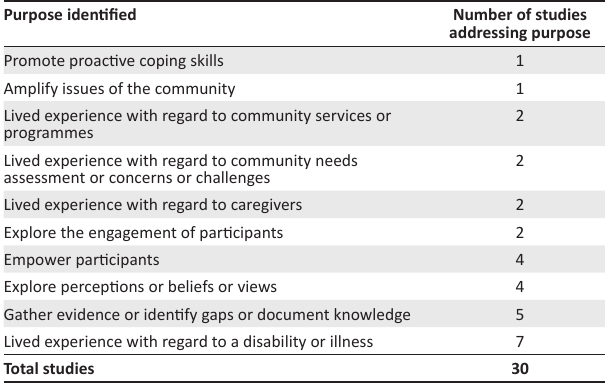
TABLE 1: Purposes addressed by